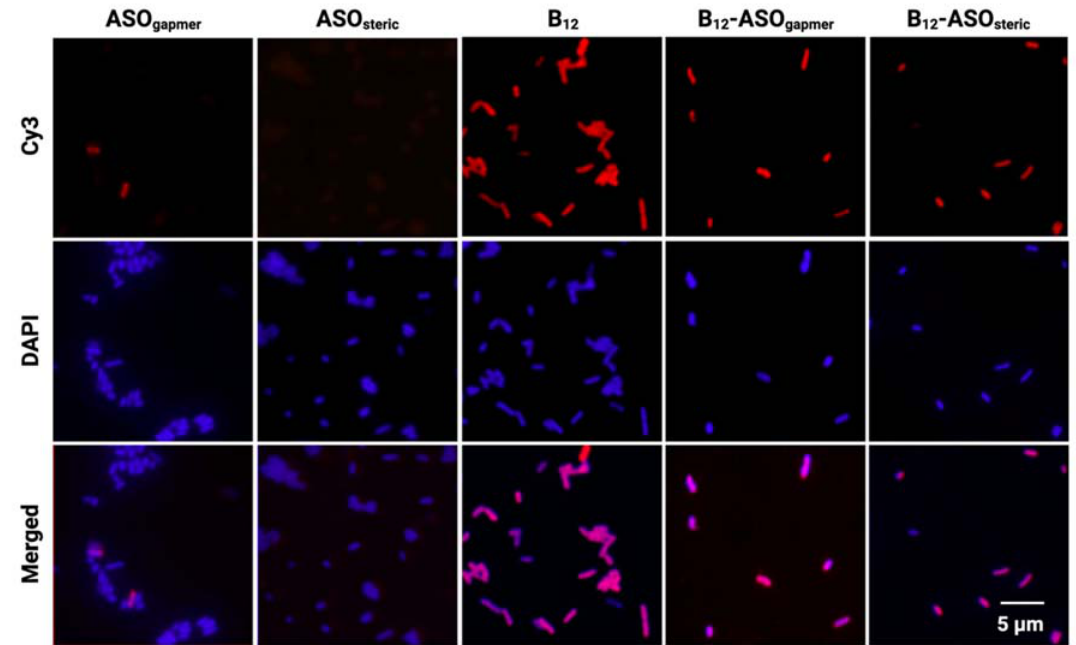
Figure 4. Interaction of Cy3-labeled ASOs, B 12, and B 12 conjugates (concentration of 30 μ M) with E. coli K12 after 4 h. Bac- teria are counterstained with 4 ′ ,6 ′ -diamidino-2-phenylindole (DAPI). Images are representative of three independent ex- periments (using duplicates in each). Scale bar represents 5 μ m.